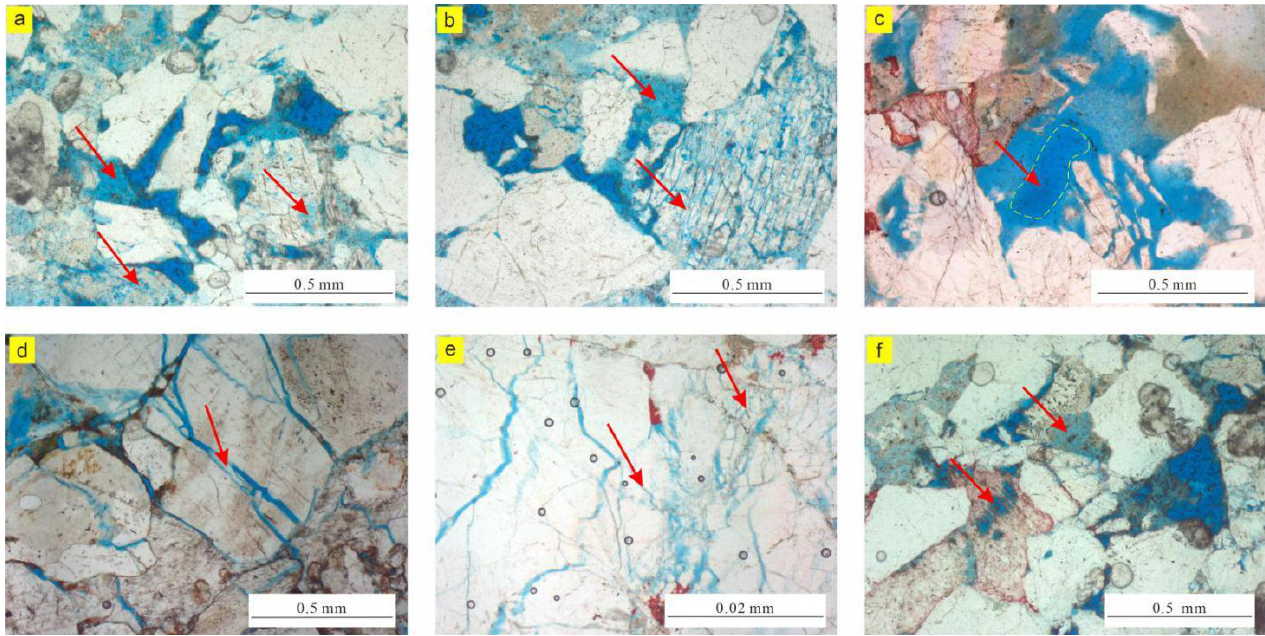
Figure 9. Characteristics of dissolution in Lower Jurassic reservoir in the Niudong area: ( a ) N1, 2232.5 m, intergranular dissolution pores in feldspar, intragranular dissolution pores; ( b ) N1, 2225.6 m, intragranular dissolution pores, intergranular dissolution pores; ( c ) N102, 2119.5 m, the whole feldspar is dissolved to form moldic pore; ( d ) N104, 2052.4 m, feldspar dissolution along the cleavage crack or fracture; ( e ) N106, 2814.0 m, feldspar dissolution along the cleavage crack or fracture; ( f ) N1, 2232.5 m, debris is dissolved, calcite is dissolved.